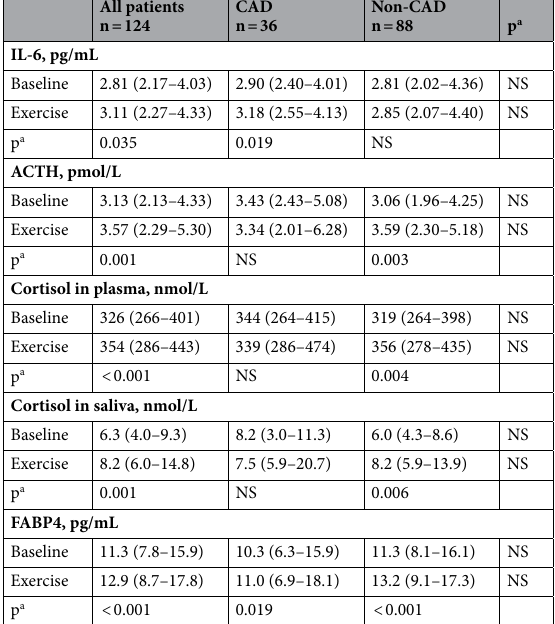
Table 3. Biochemical measures before and after exercise in all patients and patients divided into two subgroups: those with documented CAD, defined as a history of prior MI and/or coronary revascularization and/or a myocardial perfusion deficit, and those with no signs of CAD, i.e. no history of prior CAD events and normal SPECT MPI (non-CAD). a CAD vs non-CAD. Baseline vs exercise. IL-6, interleukin-6; ACTH, adrenocorticotrophic hormone; FABP4, fatty acid binding protein-4.